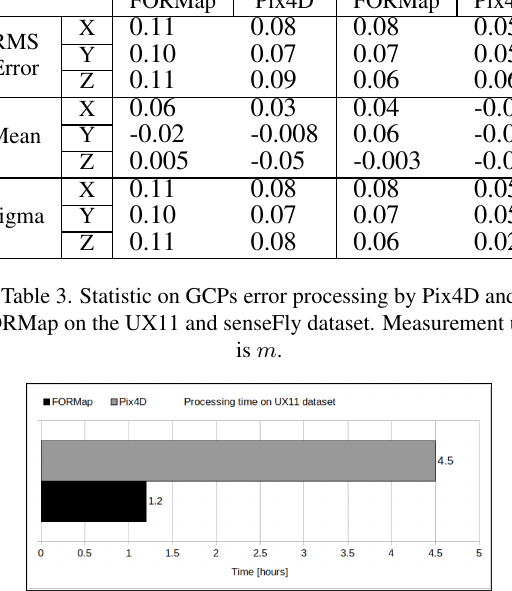
Figure 6. Comparison on processing time of UX11 dataset. Black line : FORMap, Grey line : Pix4D